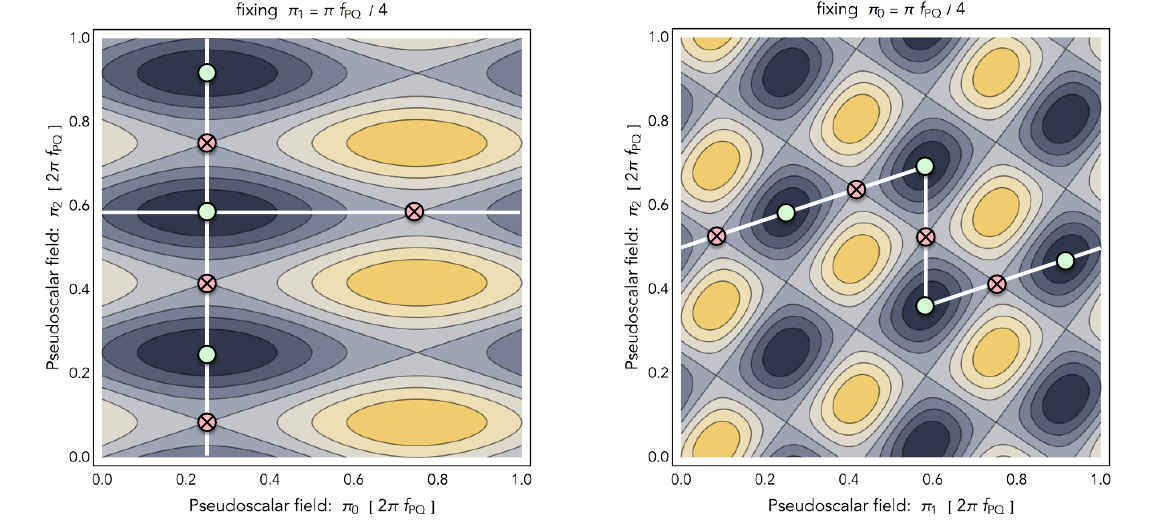
Figure 3 . For the model with three pseudoscalar (cid:12)elds ( (cid:25) 0 , (cid:25) 1 , and (cid:25) 2 ) we show the scalar potential over slices of the (cid:12)eld space, and we overlay the trajectories corresponding to the (cid:25) 0 -, (cid:25) 1 -, and (cid:25) 2 - (cid:0) (cid:1) strings. The potential is V = m 2 f 2 pq cos[ (cid:18) 0 3 (cid:18) 1 ]+cos[ (cid:18) 1 3 (cid:18) 2 ] where (cid:18) i (cid:25) i =f pq . As we encircle G (cid:0) (cid:0) (cid:17) a (cid:25) 0 -string in spacetime, the (cid:12)elds pass along the horizontal white line (left panel) from the local minimum (green dot) to the saddle point (red cross), and back to the local minimum; therefore, the (cid:25) 0 -string is connected to 1 domain wall. Similarly the (cid:25) 2 -string, which corresponds to the vertical white line (left panel), connects to 3 domain walls, and the (cid:25) 1 -string, which is shown on the right panel, connects to 4 domain walls. This discussion readily generalizes to N + 1 > 3. (The \local minima" are all connected by a (cid:13)at direction, which is the axion